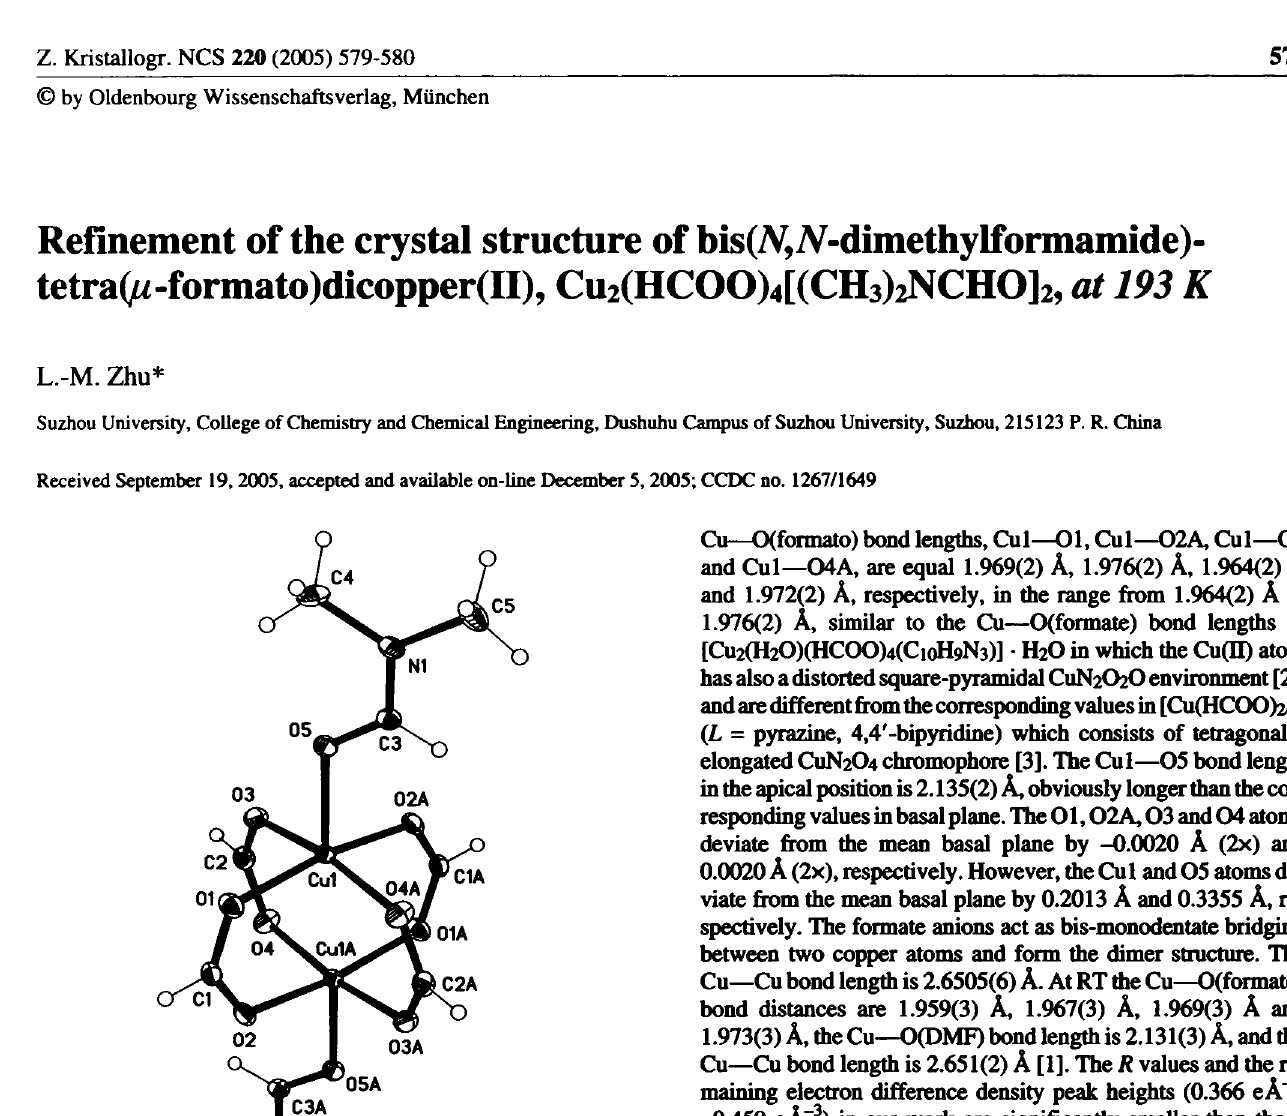
Table 1. Data collection and handling.